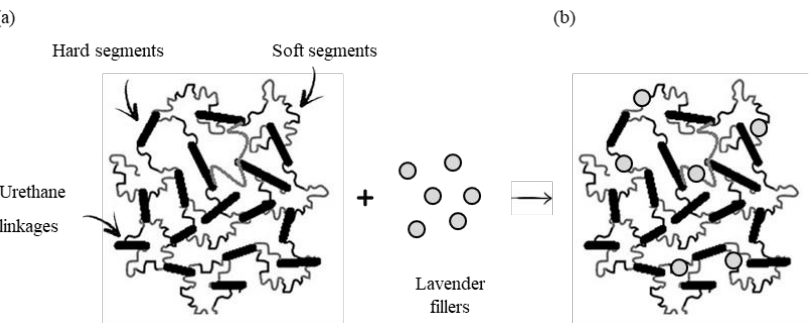
Figure 9. The impact of lavender filler addition on the cross-linking of PUR composites—( a ) PUR_REF, ( b ) PUR composites with the addition lavender fillers.